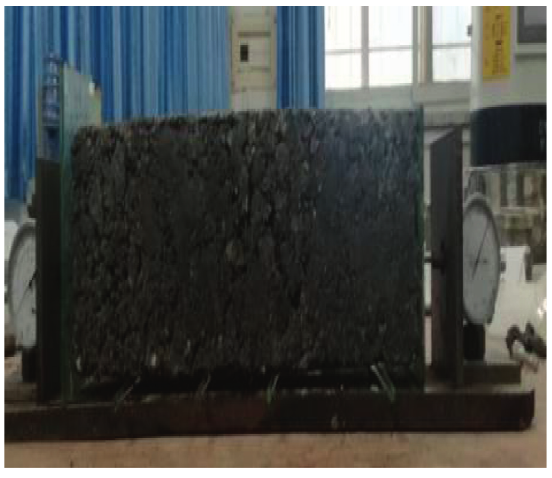
Figure 8: Dry shrinkage test device and specimen.